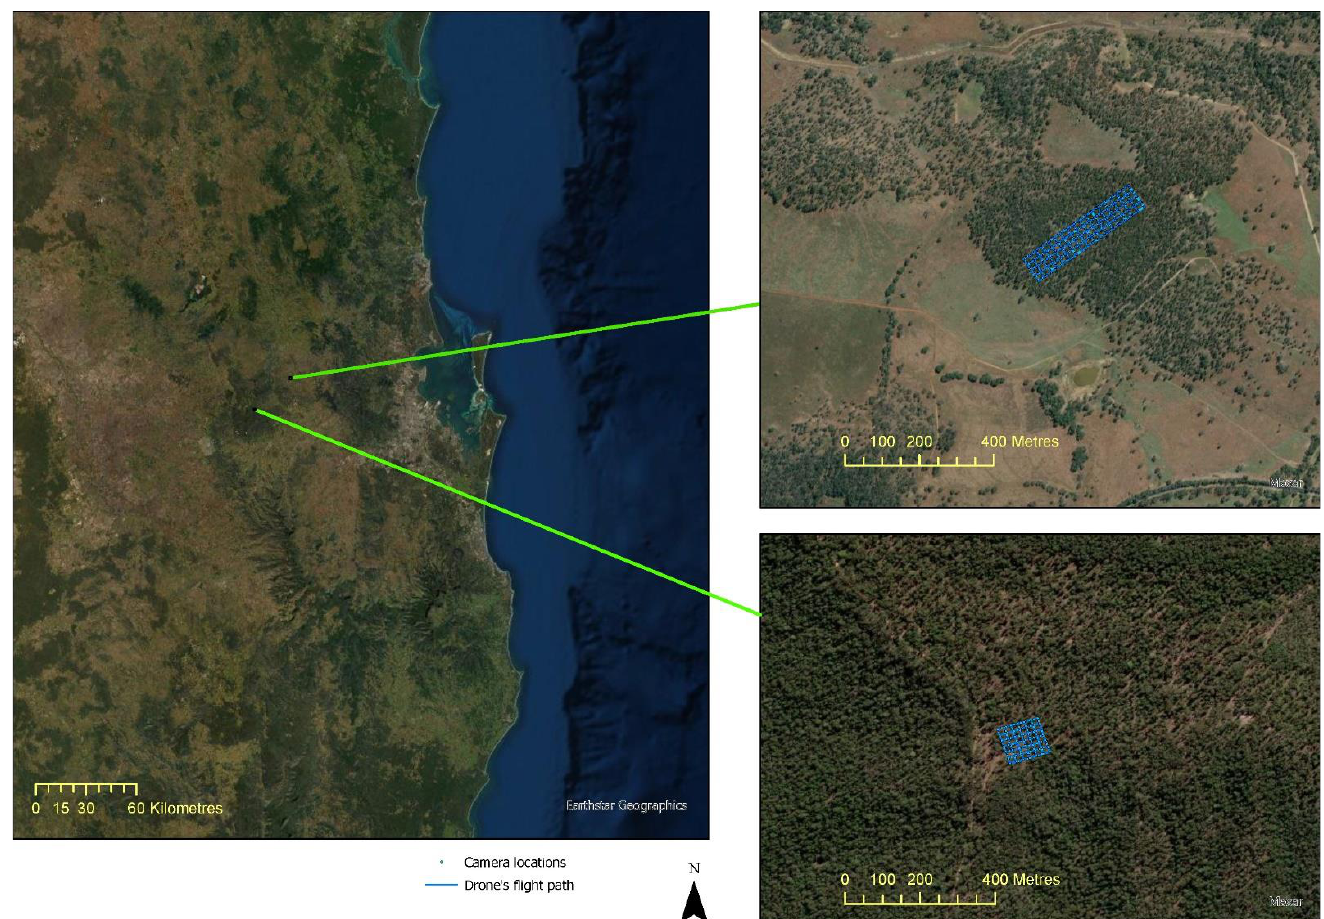
Figure 1. Location of private native forest sites selected for the study and the drone flight path used to collect images. Sites were located near Ravensbourne (site 1) and Esk (site 2). Background true colour images are from different remote-sensing satellites available in ESRI base maps.